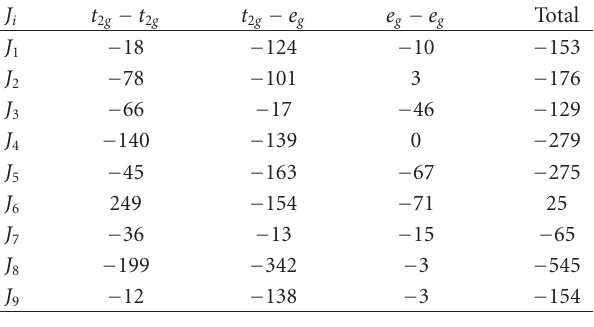
Table 4: Total and partial intraribbon exchange interaction param- eters are shown [211]. The values are given in kelvin. The spatial representation of all these exchanges is schematically presented in Figure 19.